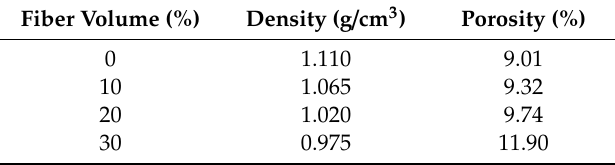
Table 1. Results for density and porosity test of the epoxy-caranan